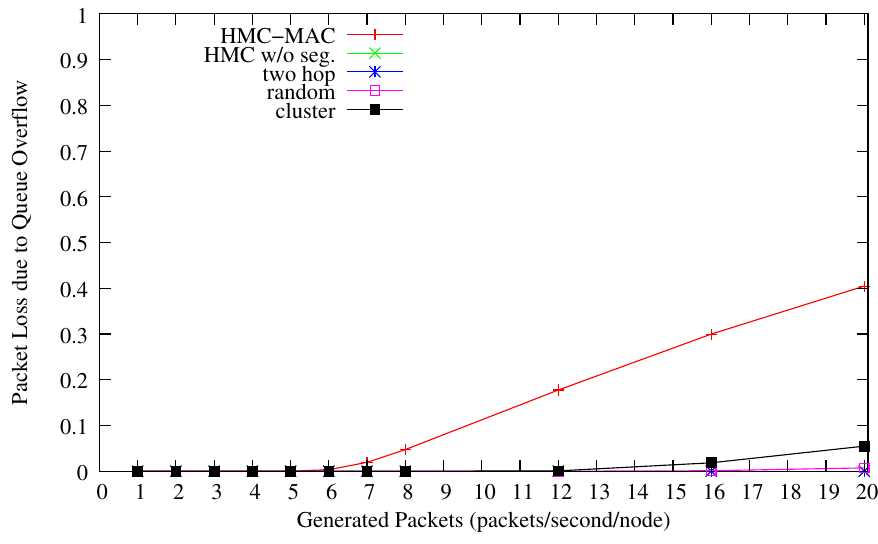
Figure 12. Packet loss due to queue overflow for burst traffic.